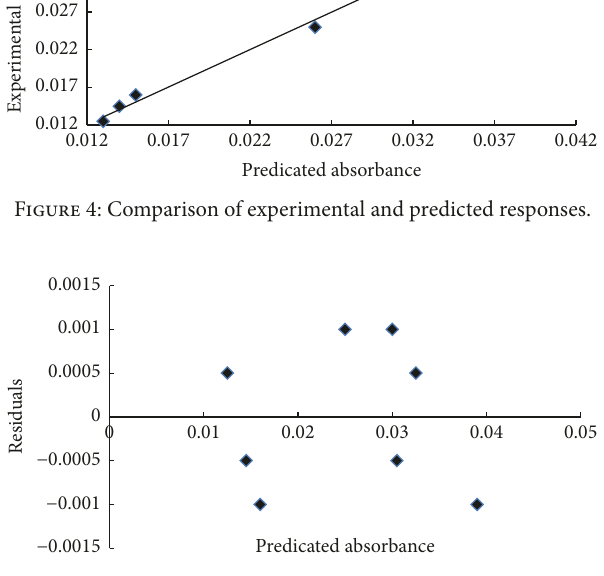
Figure 5: Residual analysis for estimated